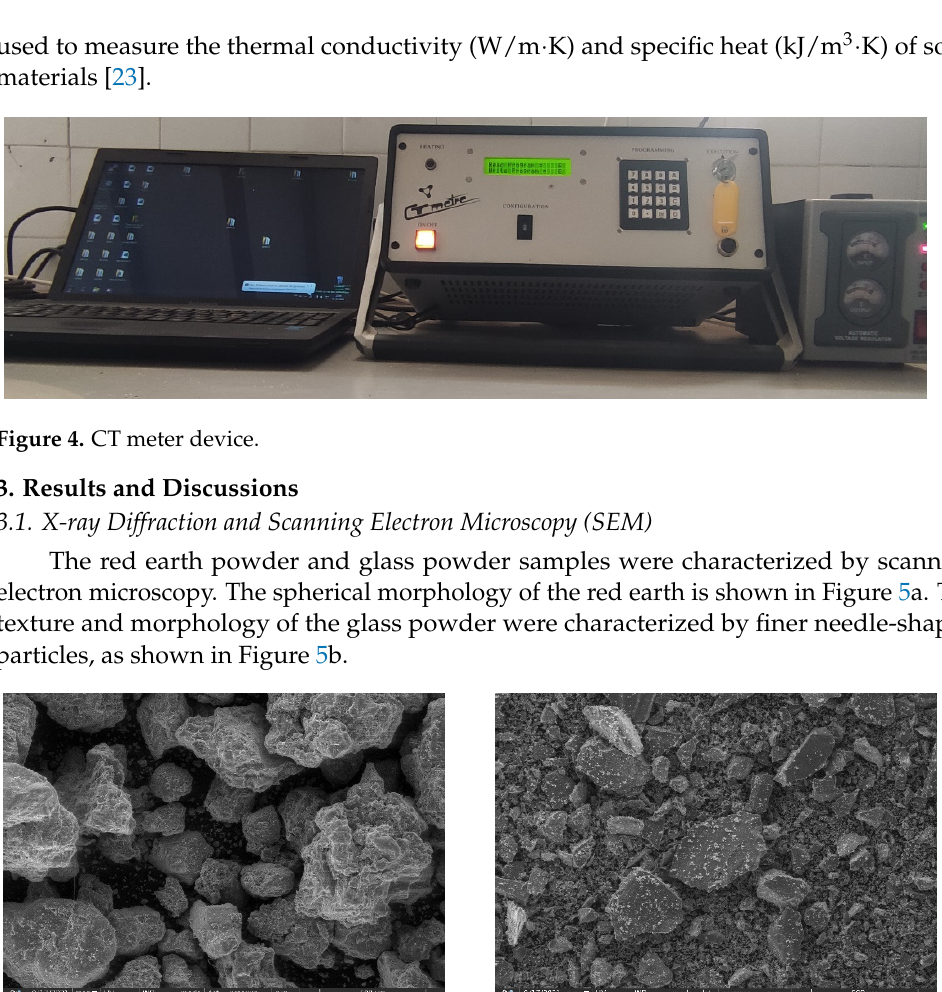
6 of 15 Figure 3. Samples of red earth blocks stabilized with cement and glass powder: ( a ) control sample (RSB); ( b ) 0% GP + 6% cement; ( c ) 0% GP + 12% cement; ( d ) 10% GP + 0% cement; ( e ) 10% GP + 6% cement; ( f ) 10% GP + 12% cement; ( g ) 20% GP + 0% cement; ( h ) 20% GP + 6% cement; ( i ) 20% GP + 12% cement; ( j ) 30% GP + 0% cement; ( k ) 30% GP + 6% cement; ( l ) 30% GP + 12% cement. 2.3. Methods X ‐ ray powder diffraction patterns were collected at room temperature (25 °C), over the 2 θ angle range of 10° ≤ 2 θ ≤ 60° with a step size of 0.04°, using a Siemens D5000 (Au ‐ brey, Texas, USA)diffractometer operating in Bragg configuration with a copper anticath ‐ ode with K α = 1.54056 Å. The morphology of the samples was verified using a scanning electron microscope JEOL IT 100 type MEOL (JEOL, Tokyo, Japan). In order to allow a minimum particle size of 4 nm, a thin layer of gold was useful to make the surface more conductive. The MEOL used in this study was associated with an energy ‐ dispersive spectrometer (EDS) to deter ‐ mine the atomic composition of the sample. The thermal properties were measured by a CT meter device (standard) delivered by